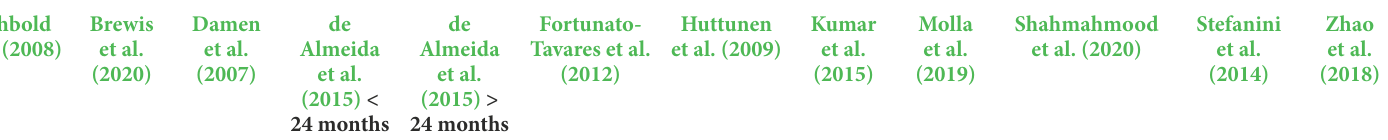
TABLE 9 Effects of implantation subscale Tukey HSD post-hoc mean